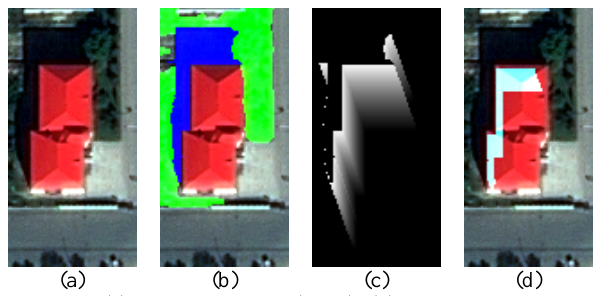
Figure 3. (a) Geoeye-1 image (RGB), (b) the detected shadow (blue) and vegetation (green) masks. (c) Fuzzy landscape generated from the shadow object with the proposed line-based non-flat structuring element, (d) the final foreground pixels ( T F ) overlaid with the original image.